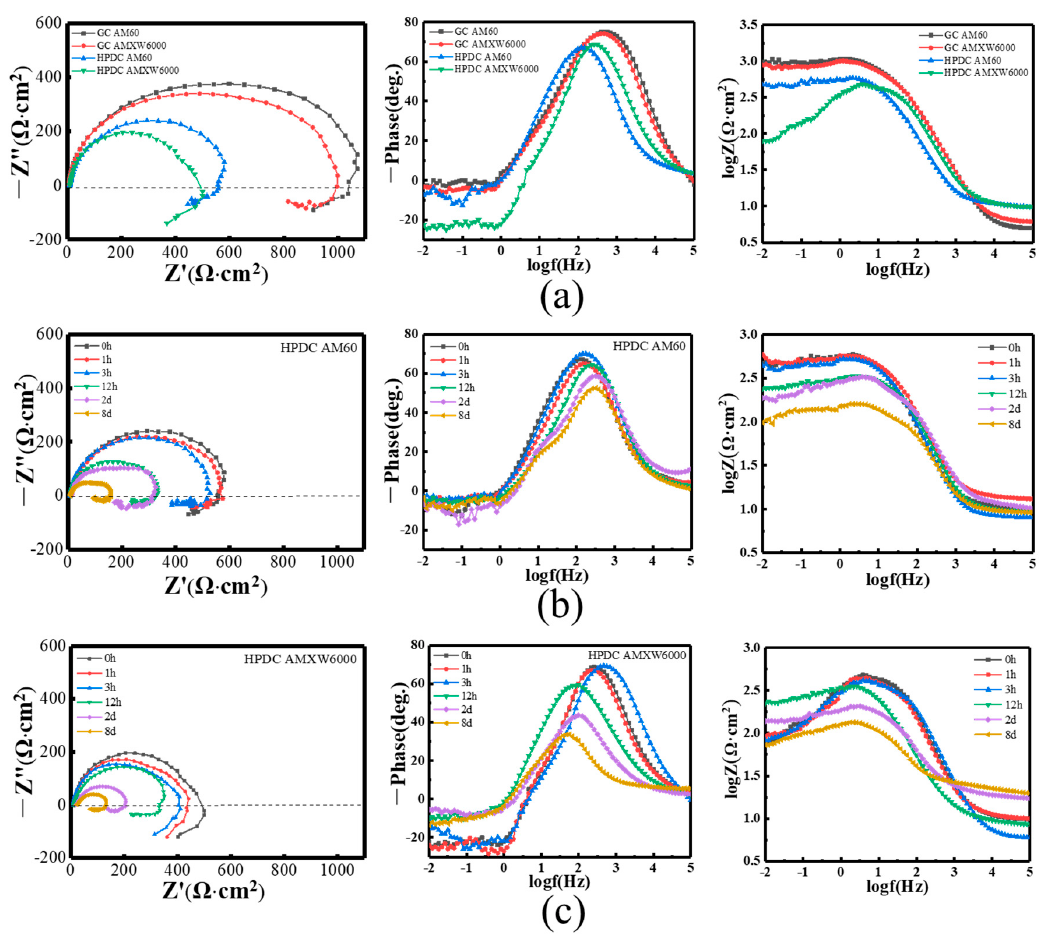
Figure 12. Nyquist plots and Bode impedance plots of ( a ) as-received GC and HPDC samples, ( b , c ) HPDCed AM60 and AMXW6000 alloy with different corrosion times, respectively. ( b , c ) HPDCed AM60 and AMXW6000 alloy with different corrosion times,